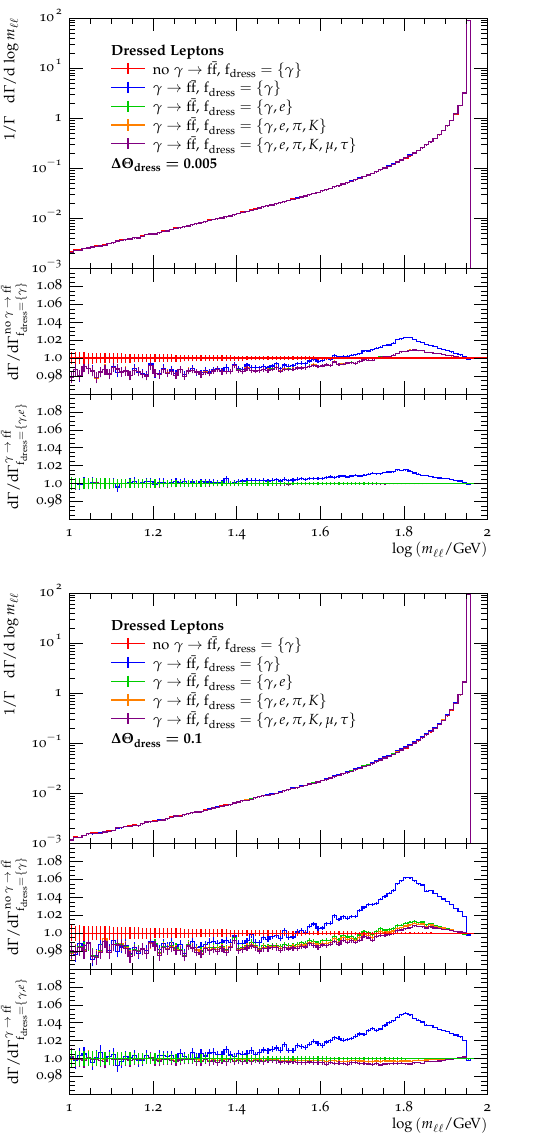
Figure 9 . The dressed dilepton invariant mass m ‘‘ as described by the YFS soft-photon resumma- tion only (red) or additionally resolving the photons further into pairs of charged particles for four different dressing cone sizes, ∆Θ dress = 0 . 005 (top left), 0 . 02 (top right), 0.1 (bottom left), and 0.2 (bottom right), in the mixed ordering scheme. We differentiate various different dressing strategies, recombining photons only (blue), photons and electrons (green), photons, electrons and charged hadrons (orange), and all charged particles (violet) within the dressing cone with the primary charged lepton. Two ratios are presented, either taking the soft-photon resummation without pho- ton splittings (upper ratio), or the soft-photon resummation including photon splittings and dressing the primary leptons with photons as well as secondary electrons (lower ratio), as the